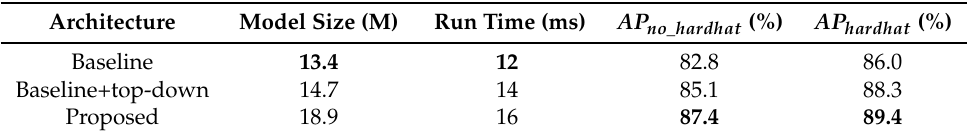
Table 1. Performance comparison of different network architectures (bold indicates either best performance or minimum cost).